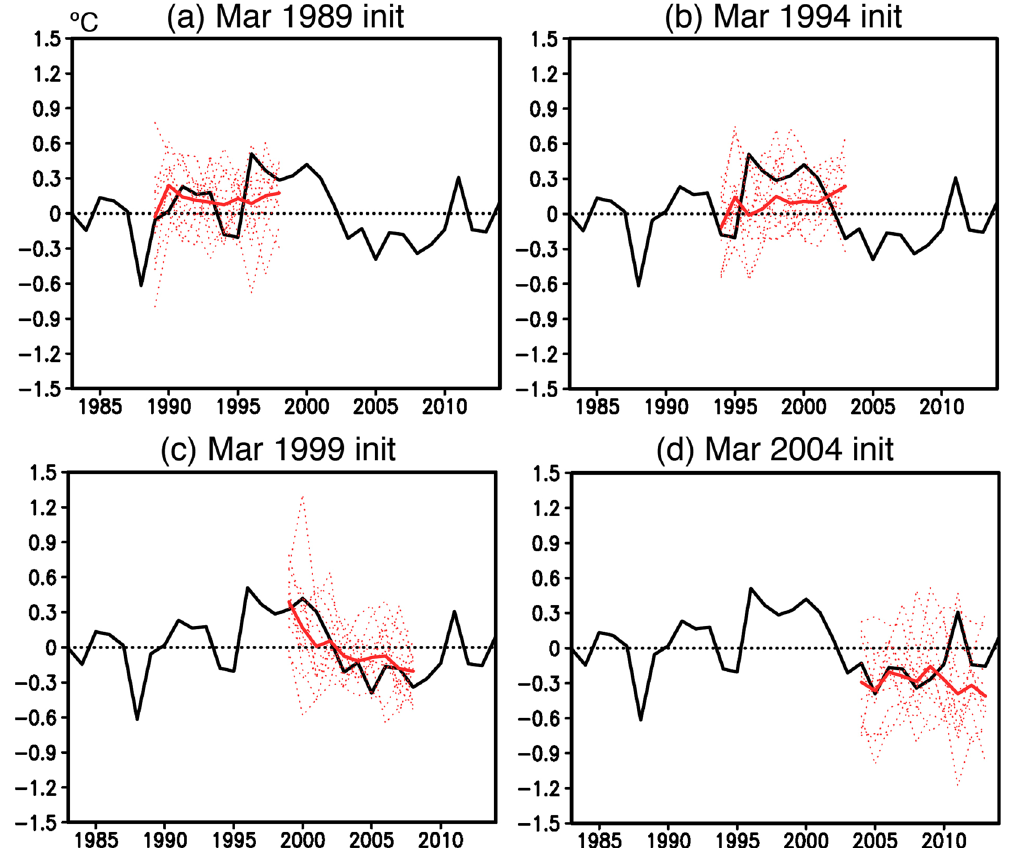
Figure 2. ( a ) Time series of yearly mean SWIO indices (in °C). Observation (black line) and reforecast experiments (red lines) initialized from March 1st 1989 are shown. The thick red line corresponds to 12 ensemble mean results, whereas the thin red dotted lines correspond to each ensemble member. ( b – d ) Same as in ( a ), but for the other reforecast experiments initialized from March 1st in 1994, 1999, and 2004, respectively.